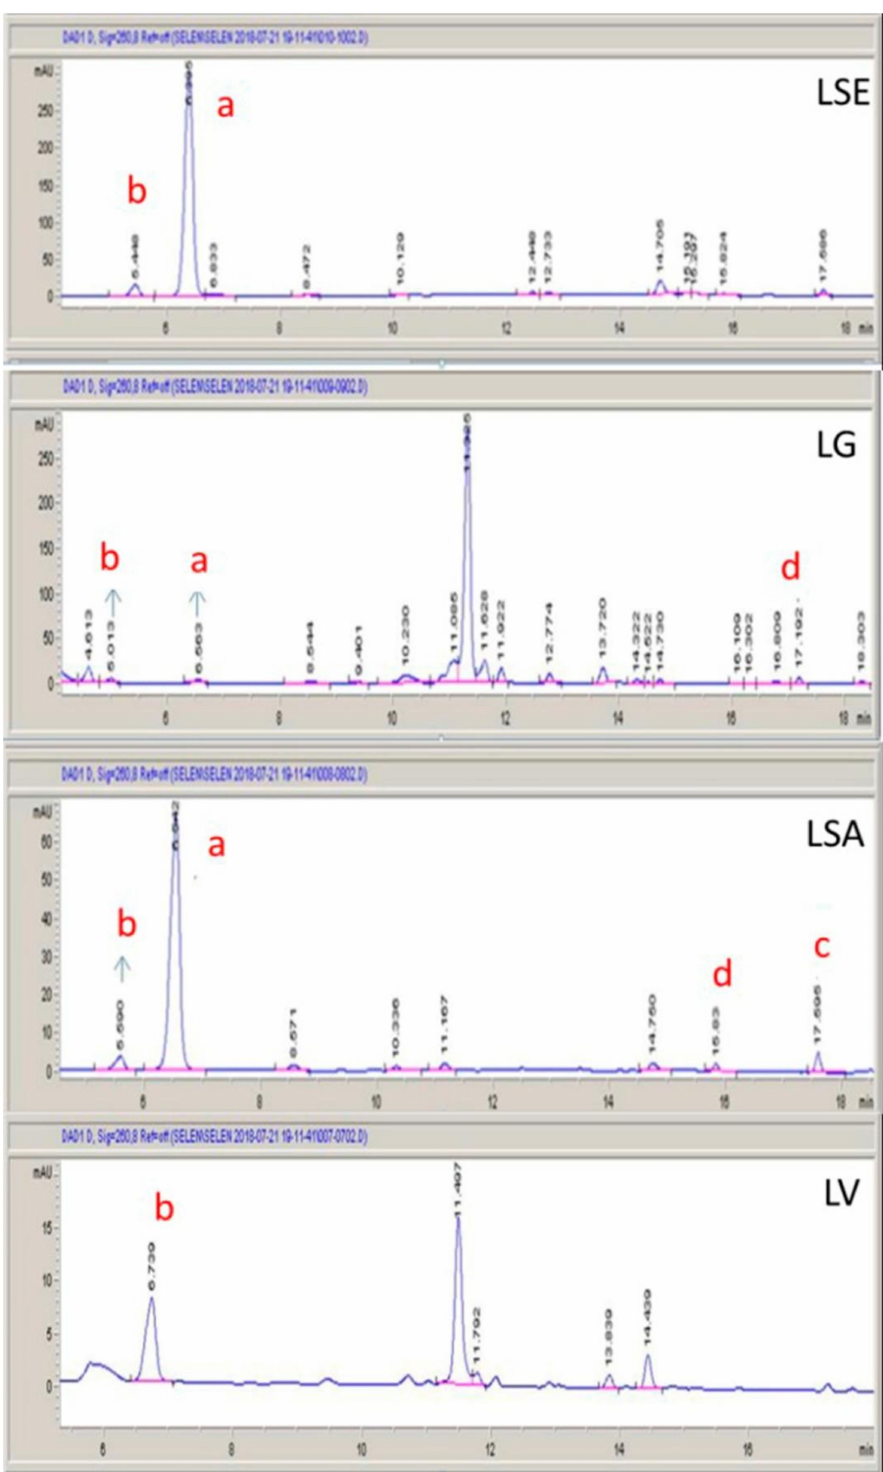
Figure 3. HPLC chromatograms of the latexes. LSE: L. serriola latex, LG: L. glareosa latex, LSA: L. saligna latex, LV: L. viminea latex. Peaks: ( a ) lactucin, ( b ) 11 β ,13-dihydrolactucin, ( c ) lactucopicrin, and ( d ) 11 β